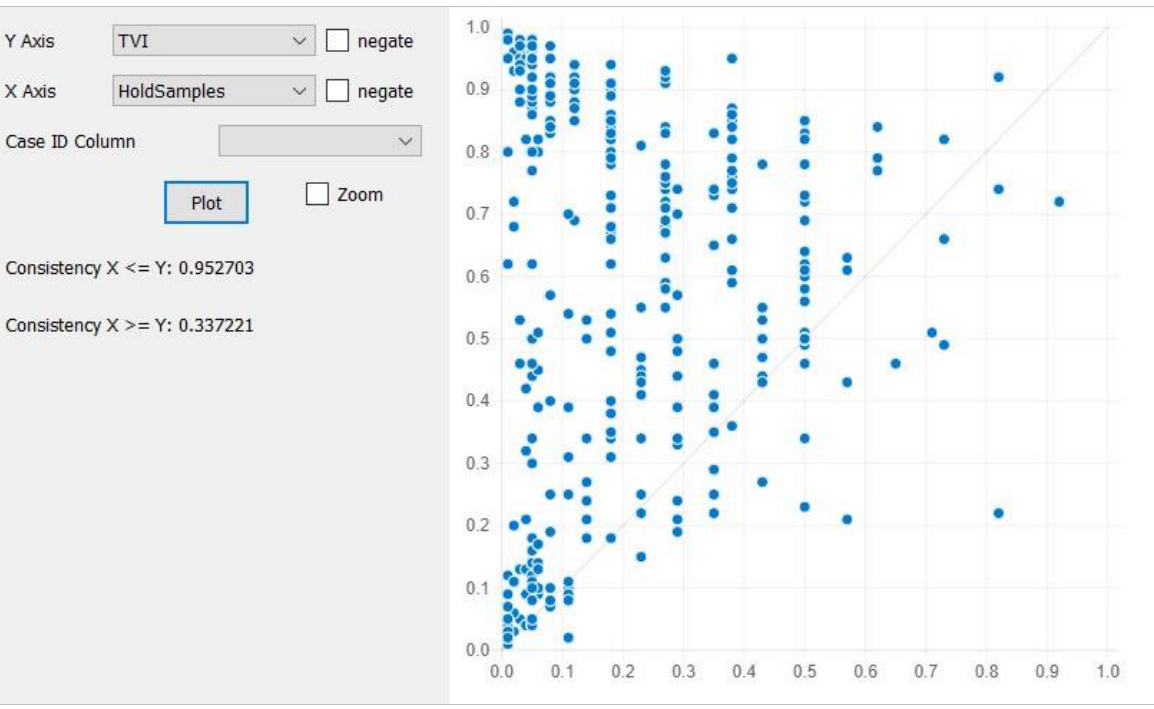
Figure 6. Preposition (*ATT, *SML, *TS, ~EXP, ~PSI)- XY Plot from Holdout Samples (preposition) with Consistency = 0.952 and Coverage =